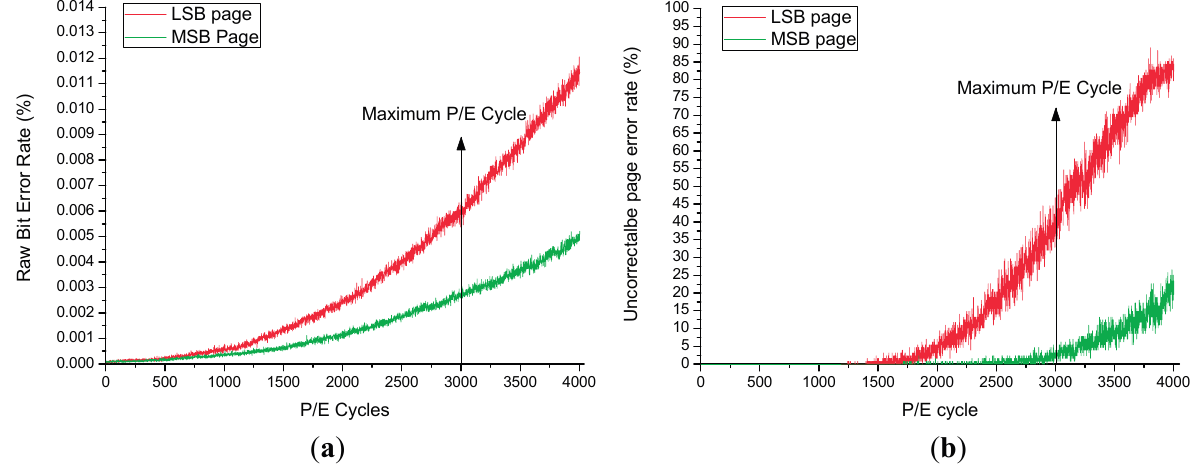
Figure 3. RBER (Raw Bit Error Rate) and uncorrectable page errors versus different P/E cycles.